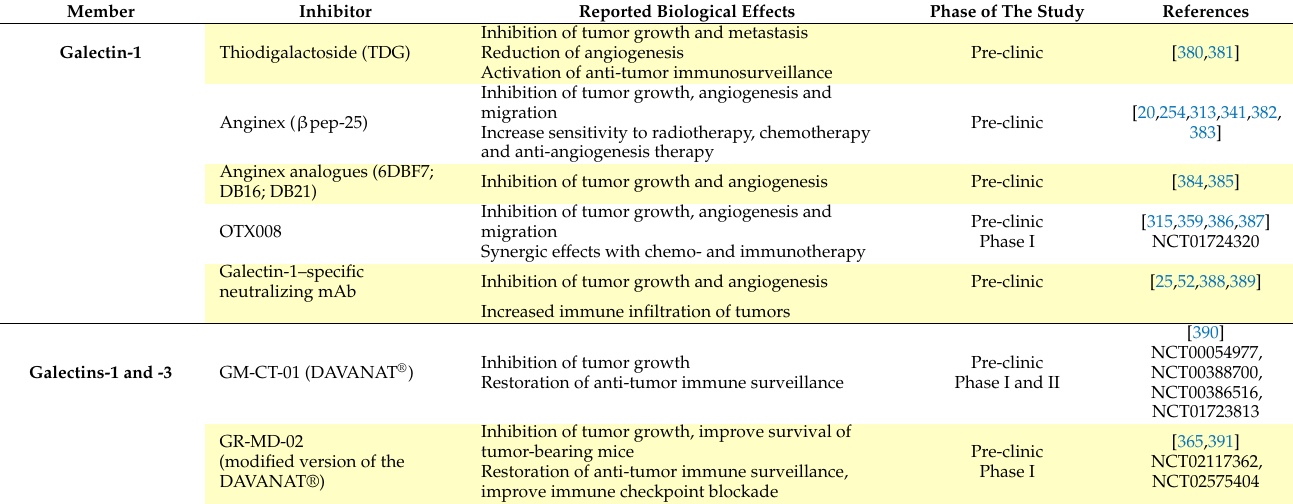
Table 2. The main inhibitors of galectins evaluated for cancer